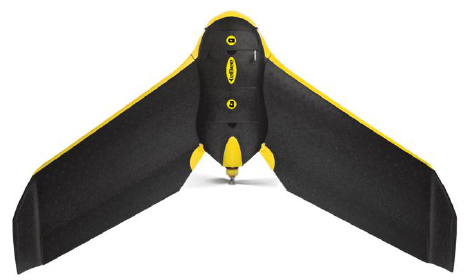
Figure 5. The Remotely piloted aircraft system (RPAS) eBee.